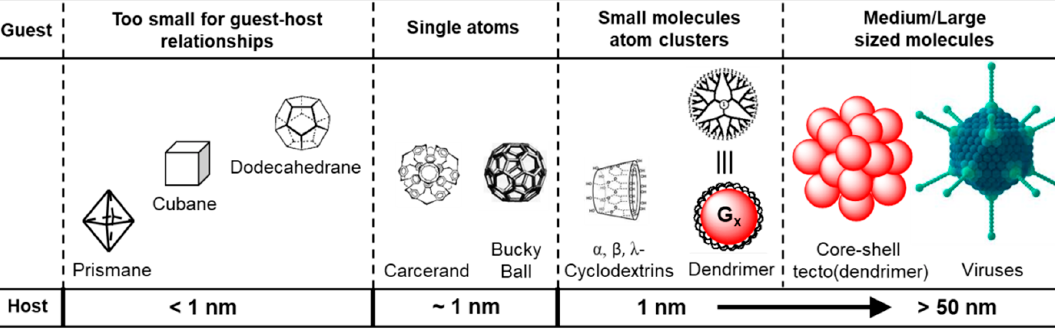
Figure 1. Evolution of closed, container-like structures as a function of dimensions and complexity.